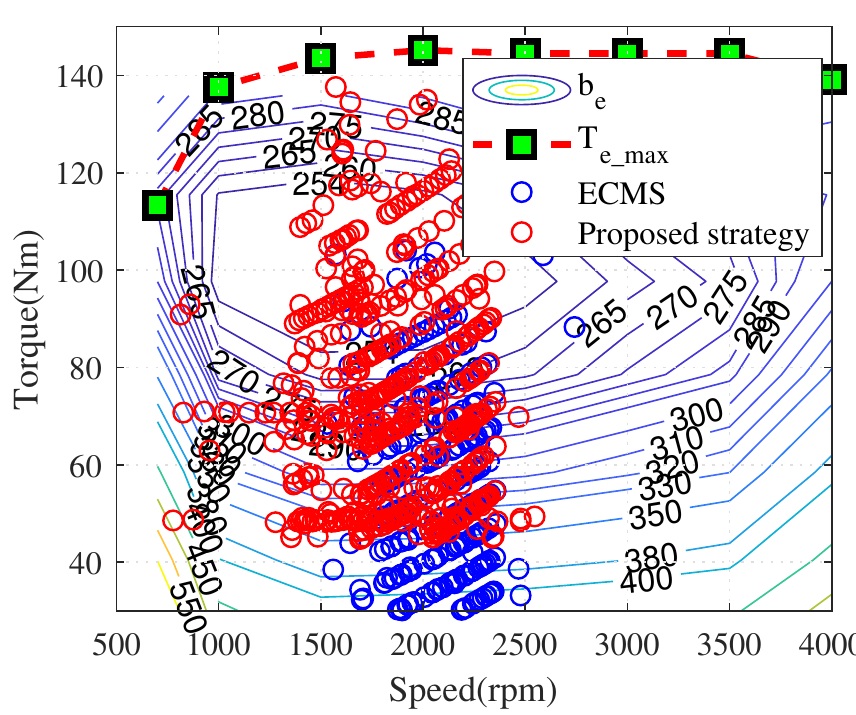
Figure 15. Engine operation points of ECMS and proposed